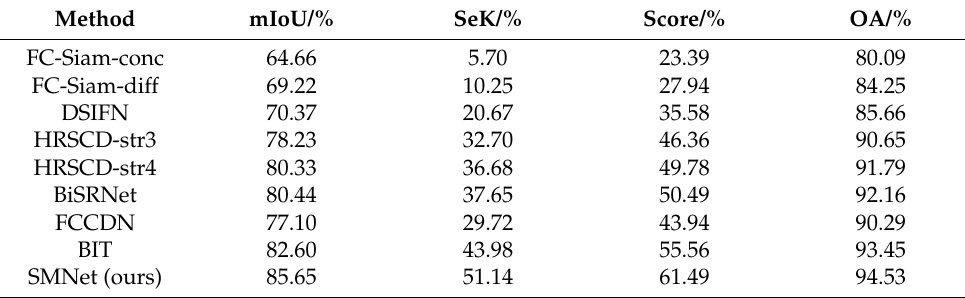
Table 2. Comparison results on Landsat-SCD